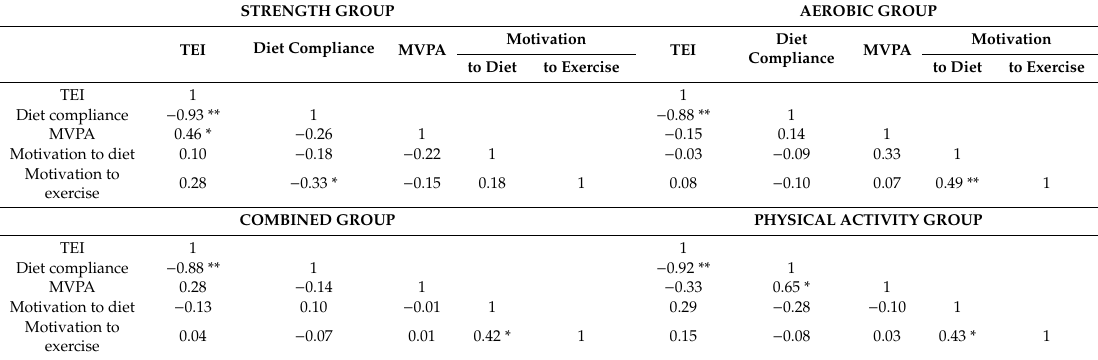
Figure 1. Time line of the Study. HRR: heart rate reserve; RM: repetition maximum; S: strength training group; E: endurance training group; SE: combined strength plus endurance training group; PA: physical activity recommendations group.